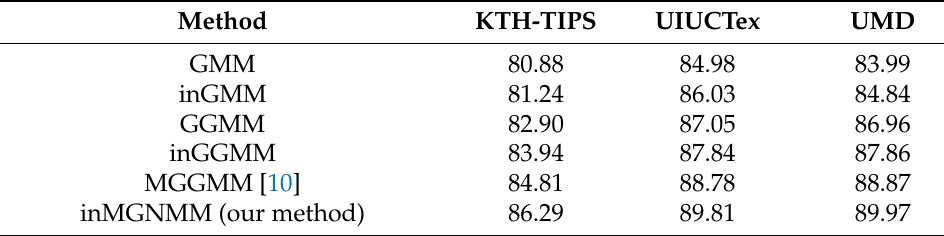
Table 2. Overall classification accuracy rate (%) of different approaches for the three texture datasets using LBP features.